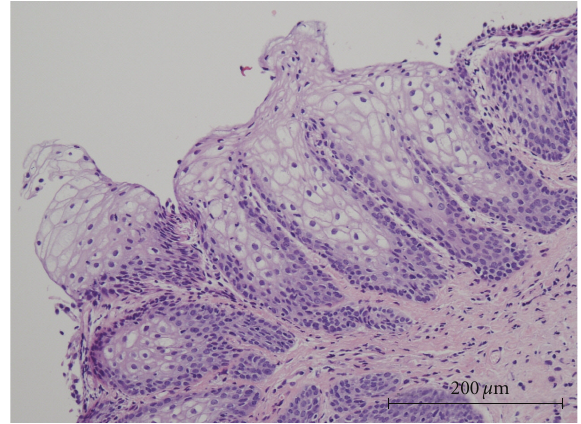
Figure 2: Hematoxylin and eosin staining of bladder squamous papilloma (HPV negative).